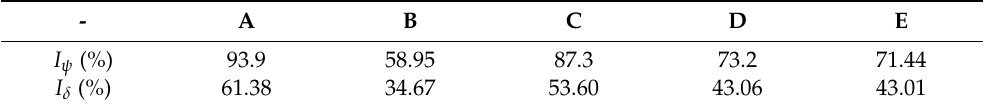
Table 5. Hydrogen embrittlement sensitivity index of different samples.